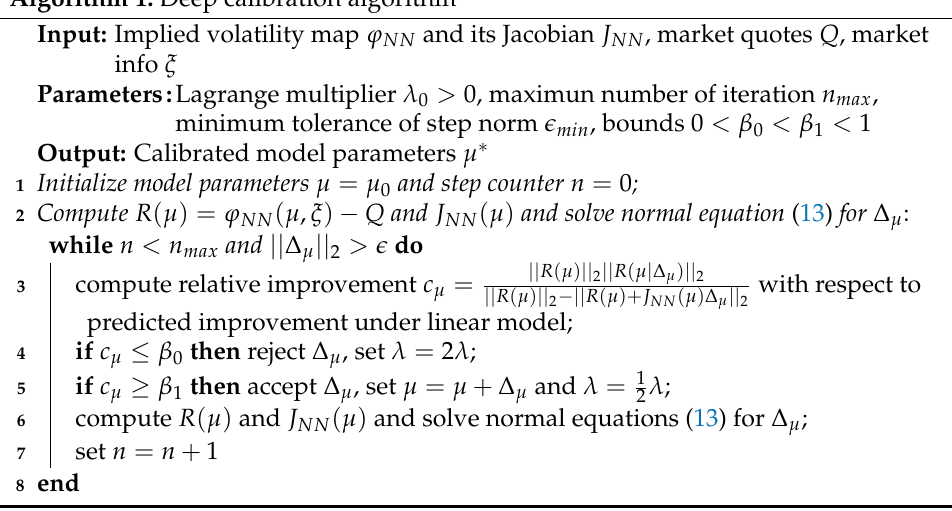
Algorithm 1: Deep calibration